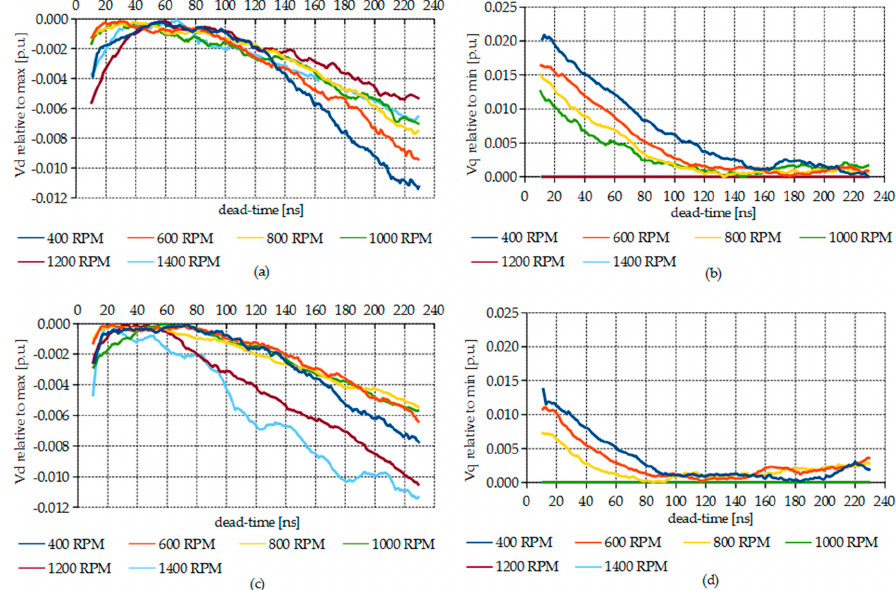
Figure 10. More detailed depiction of curves from Figure 9: ( a ) 𝑑 -axis current controller, 𝑅 (cid:2922)(cid:2925)(cid:2911)(cid:2914) = 187 Ω ; ( b ) 𝑞 -axis current controller, 𝑅 (cid:2922)(cid:2925)(cid:2911)(cid:2914) = 187 Ω ; ( c ) 𝑑 -axis current controller, 𝑅 (cid:2922)(cid:2925)(cid:2911)(cid:2914) = 73 Ω ; and ( d ) 𝑞 -axis current controller, 𝑅 (cid:2922)(cid:2925)(cid:2911)(cid:2914) = 73 Ω .